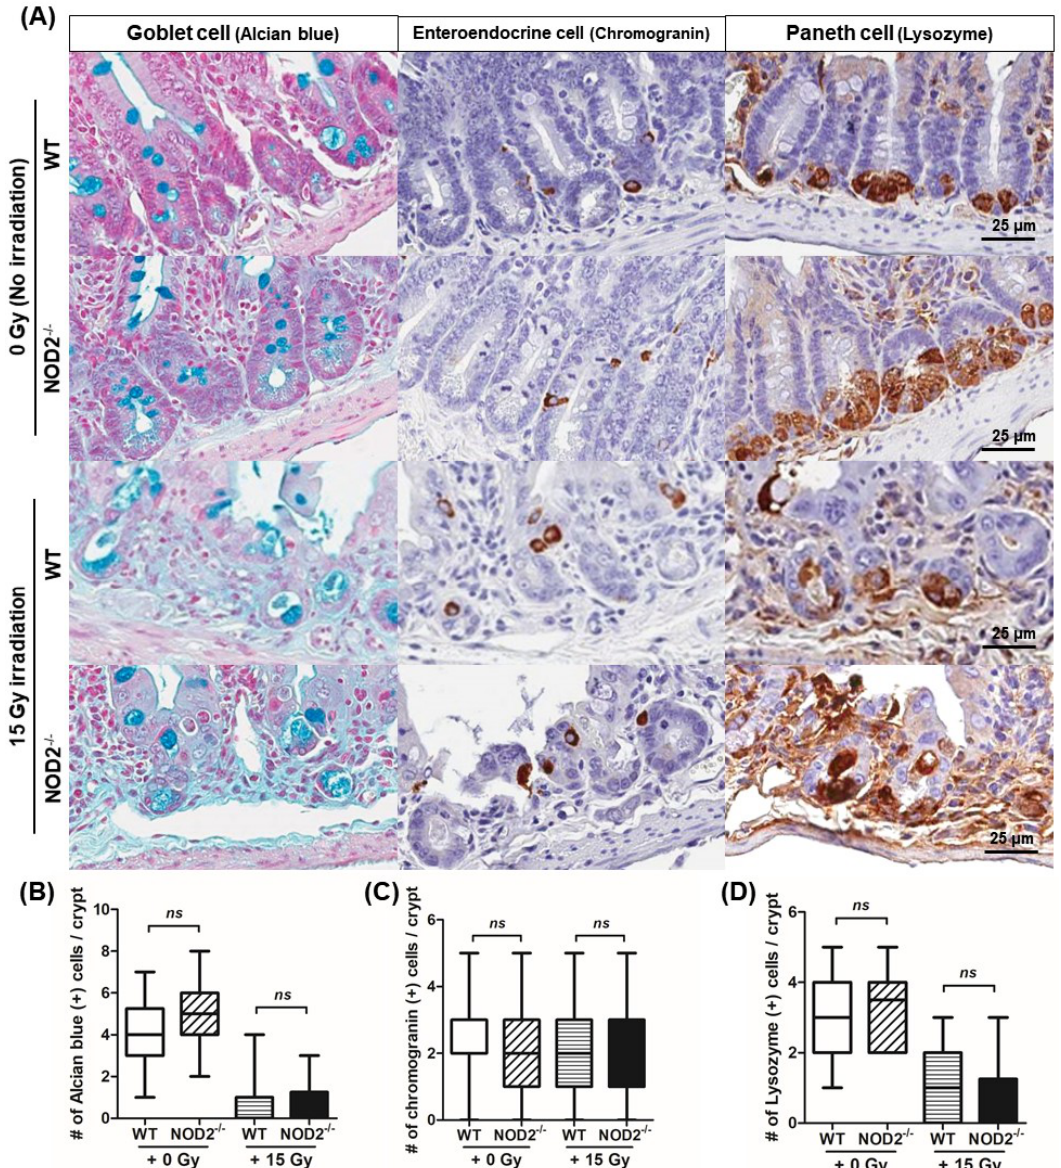
Figure 4. Immunohistochemical staining for goblet cells, enteroendocrine cells, and Paneth cells after 15 Gy irradiation in the WT and NOD2 − / − mice. ( A ) Immunohistochemical staining for goblet cells, enteroendocrine cells, and Paneth cells with alcian blue solution, chromogranin, and lysozyme antibody. ( B ) Alcian blue-stained goblet cells in the small intestinal crypt between the NOD2 − / − and WT mice, between the 0 and 15 Gy irradiations. ( C ) Chromogranin-positive enteroendocrine cells in the small intestinal crypt between the NOD2 − / − and WT mice, between the 0 and 15 Gy irradiations. ( D ) Lysozyme-positive Paneth cells in the small intestinal crypt between the NOD2 − / − and WT mice, between the 0 and 15 Gy irradiations.